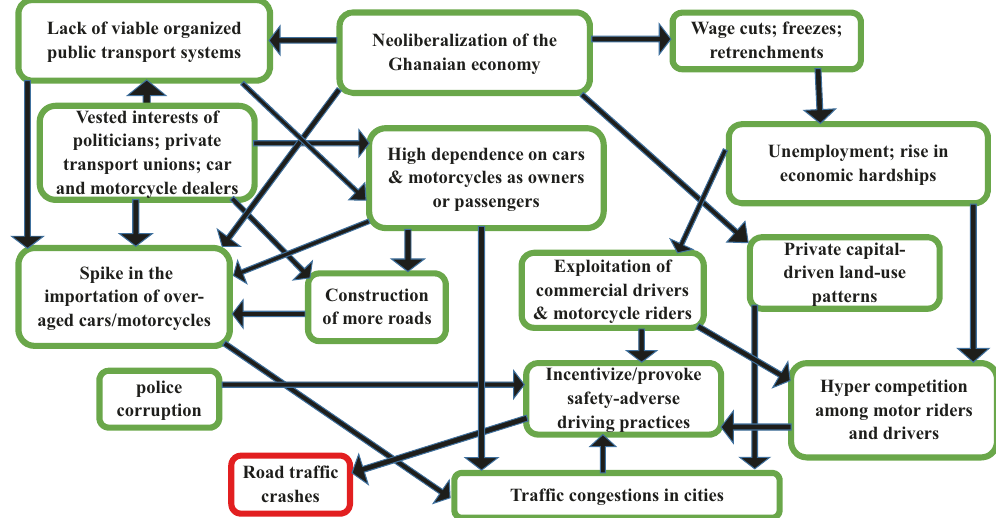
Fig. 1 Conceptual framework of in fl uences of road trauma in